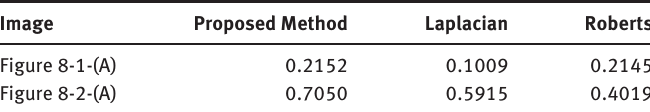
Table 4. FOM Values for Proposed, Laplacian, and Roberts Edge Detectors. Image